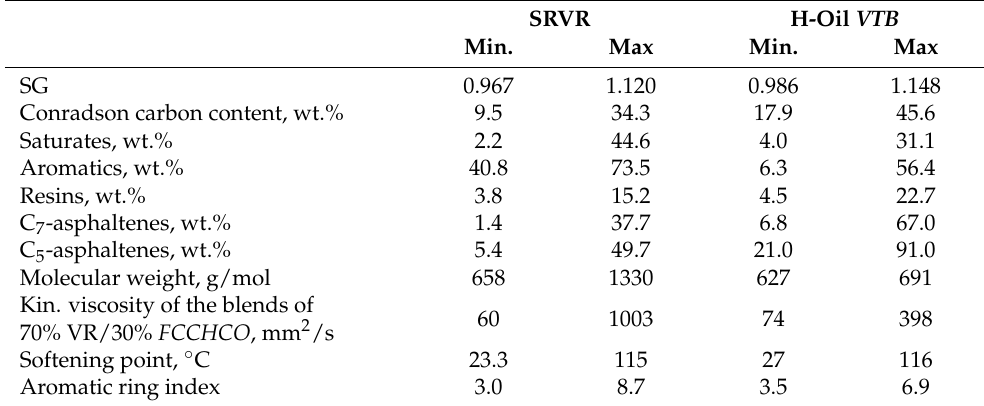
Table 4. Range of variation in SRVR and H-Oil VTB